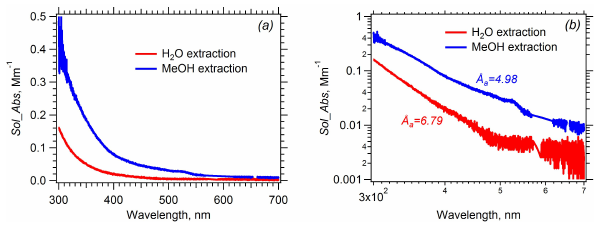
Fig. 4. Example solution spectra of H 2 O and MeOH (methanol) extracts from the same MOUDI stage (JST, 25–27 May 2012, stage 6 with particle aerodynamic diameter between 0.56 and 1.0µm). Absorption Ångström exponent is calculated by linear regression fit to logAbs vs. log λ in the wavelength range of